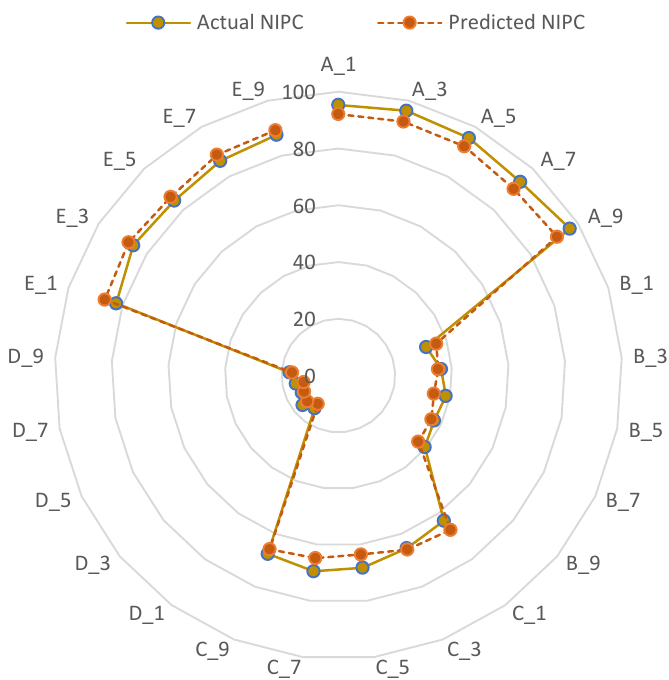
Figure 14. Demonstration of the actual and predicted NIPC values of chernozem soils on tests A_1 to E_10, implemented on layers A–E, respectively.